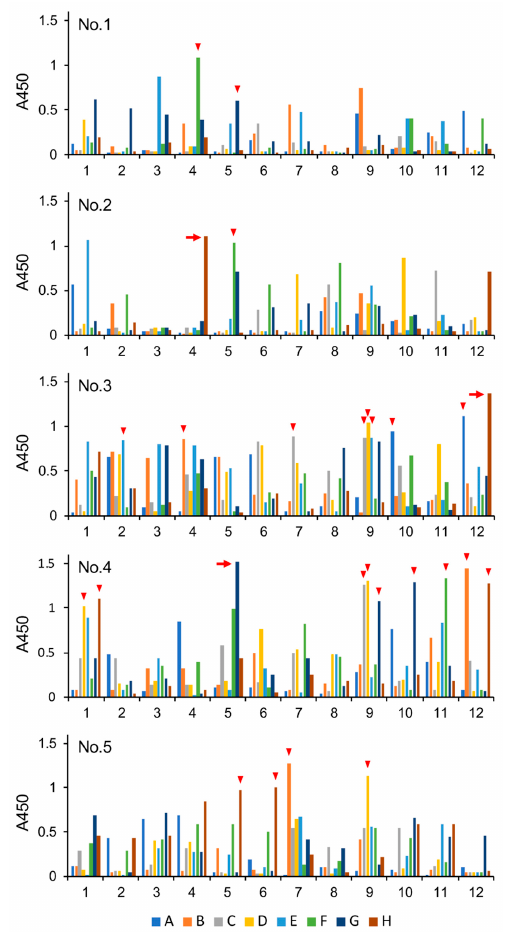
Figure 2. Reactivity of hybridoma culture supernatants against Gb4Cer. Hybridoma cells prepared from a Gb4Cer-VLCFA-immunized mouse were seeded into five 96-well microplates to grow as a single colony per well, and the reactivity of the antibodies in the supernatant of each well against Gb4Cer was analyzed by ELISA using horseradish peroxidase-labeled anti-mouse Immunoglobulin G (H + L). A through H and 1 through 12 indicate the row and well numbers of the 96-well plate. These results are summarized in Table 1. Arrows and arrowheads correspond to the clones analyzed in Figure 3. Arrows correspond to the clones established as hybridomas as follows: 4G5, PA5; 3H12, PA4.2; 2H4, PA7.